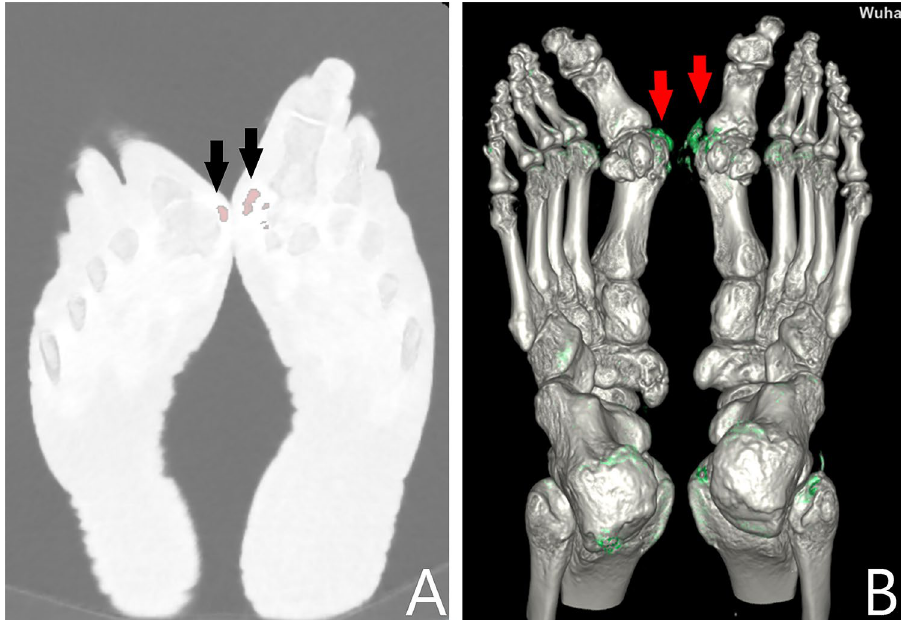
Figure 6. A 73 years old male patient has a gout duration of 10 years. Multiple stained sites [( A ), arrows] can be seen in bilateral first MTP joints on the uric acid (hydroxyapatite) map. The stained sites [( B ), arrows] can also be observed in three-dimensional volume rendering fusion